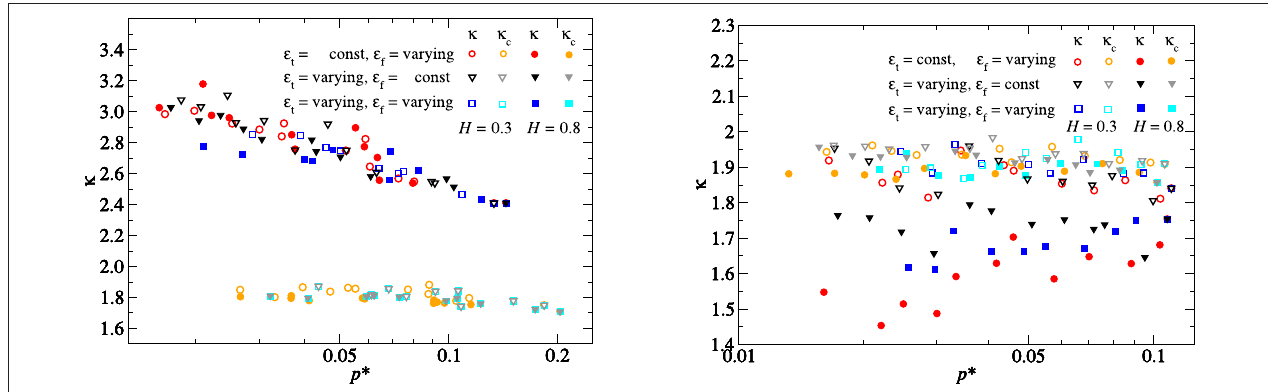
FIGURE 8 | Same as Figure 4 , however, this time for a height warped surfaces: (Left) blunt indenting peaks and steep valleys ( w shallow valleys ( w = −